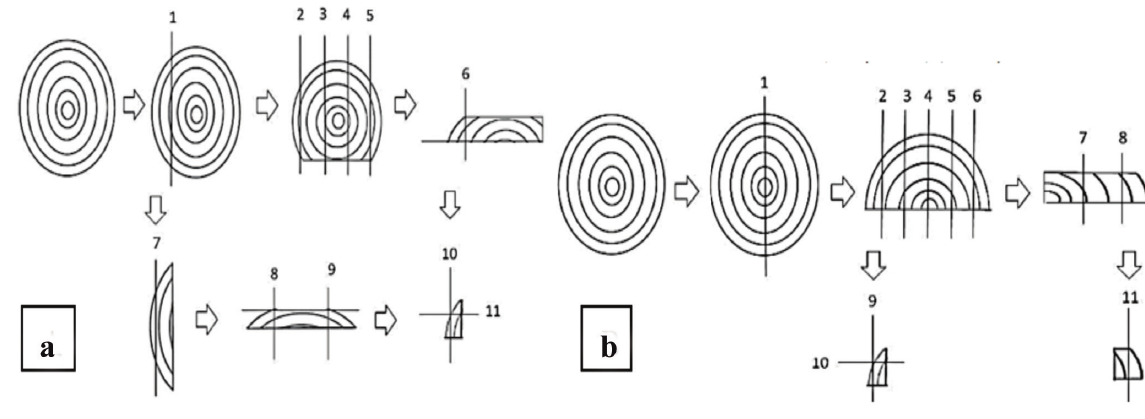
Figure 1. Alternating tangential model sawing ( a ) and radial sawing model ( b